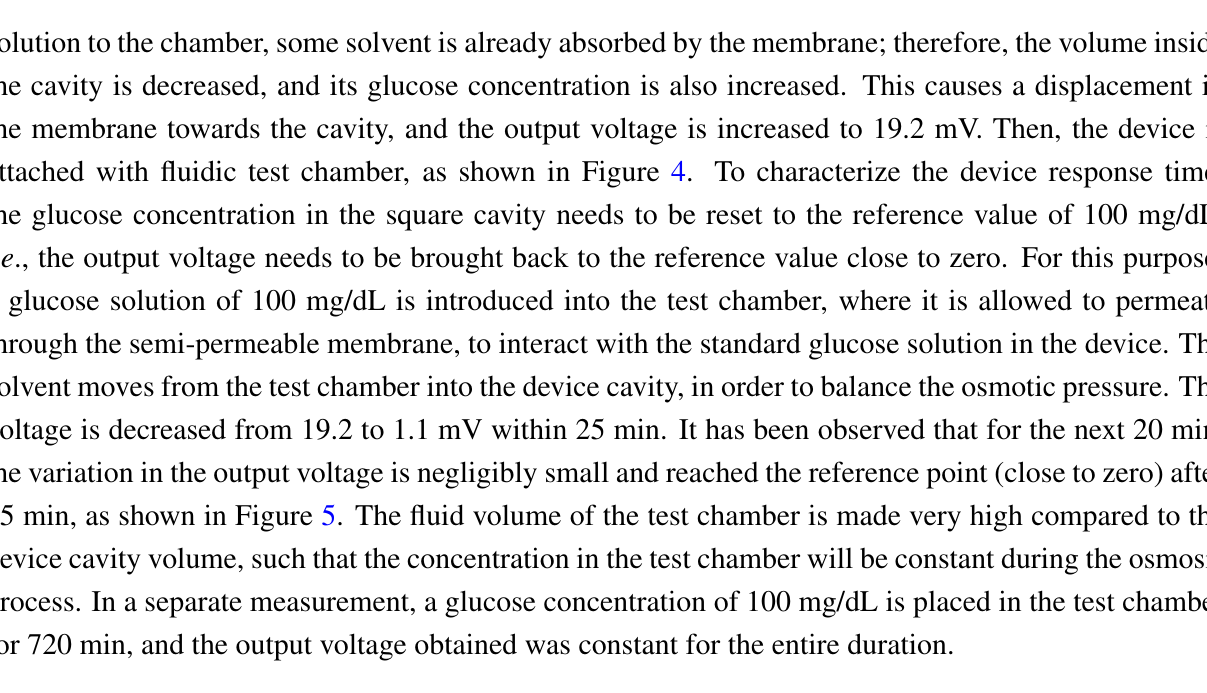
Figure 4. Glucose sensor with a testing chamber attached on the bottom side.